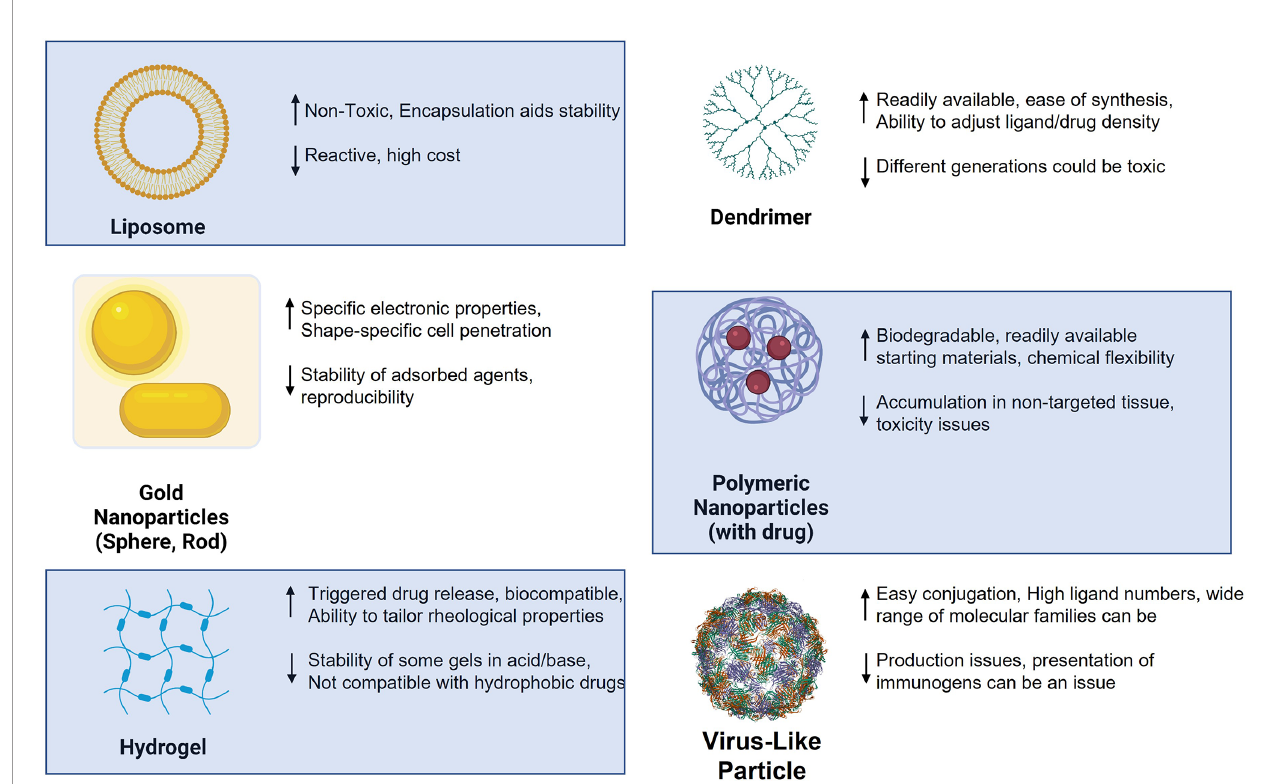
FIGURE 3 | Various nanoparticles used in antitumor therapy design and selected advantages (up arrow) and disadvantages (down